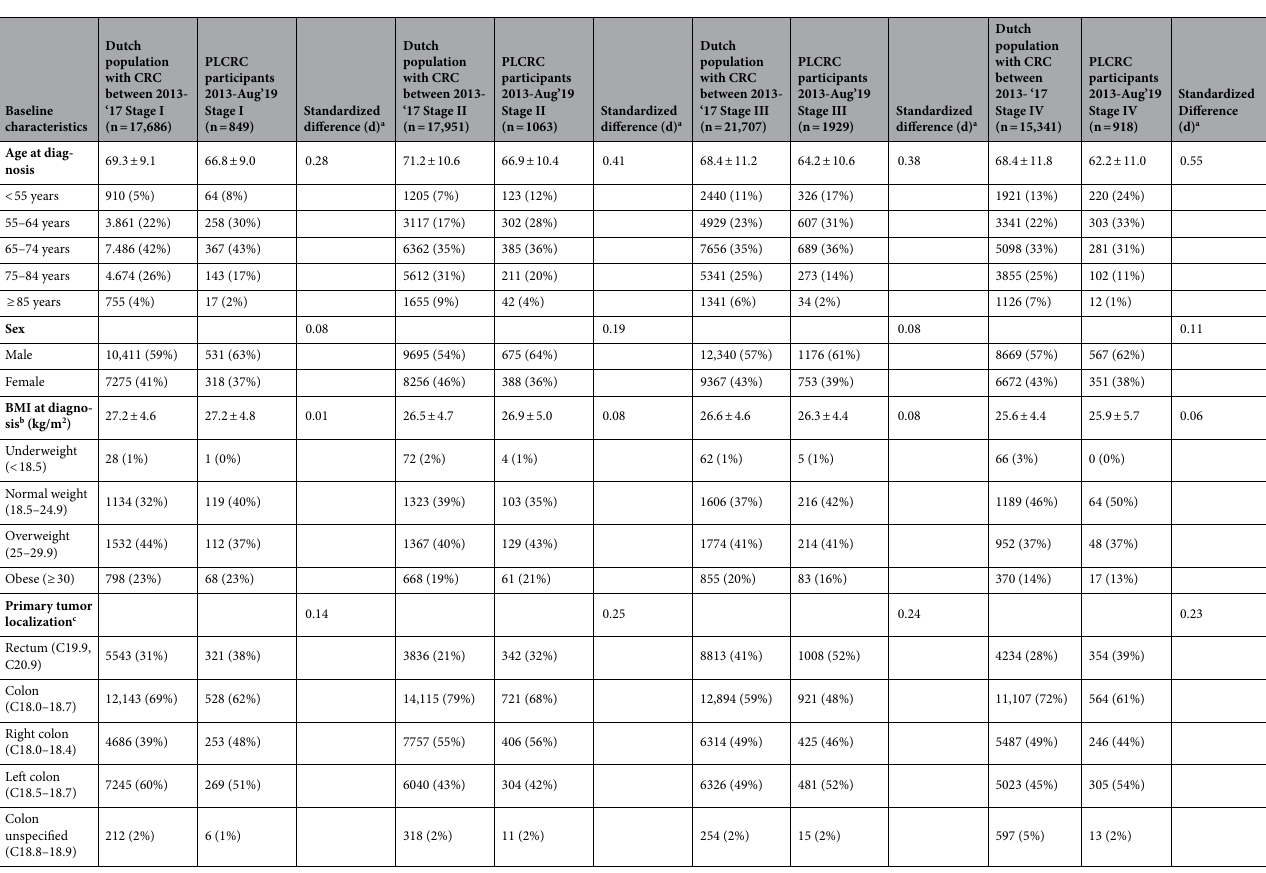
Table 3. Characteristics of the PLCRC participants at diagnosis (2013–Aug’19), compared with the general Dutch CRC population (2013–’17), stratified by tumor stage. a Standardized differences (d) are differences in means or proportions divided by standard error; d > 0.20 indicate a large difference, d 0.10–0.20 indicate a small difference, and d < 0.10 indicate a negligible difference 17,18 . b BMI at diagnosis for PLCRC only available when participants were enrolled at diagnosis and provided PROs (n = 1244); the NCR only collected height and weight in 2015, thus the reference values for BMI originate only from patients diagnosed in 2015 (n = 13,796). c Standardized differences calculated over the proportion rectum versus colon